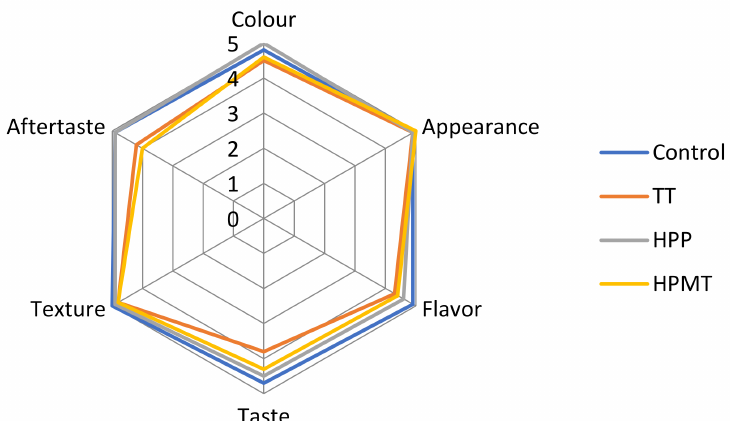
Figure 6. Sensory profile of peach–strawberry puree, representing the mean values of the individual points given by the 25 panellists for the